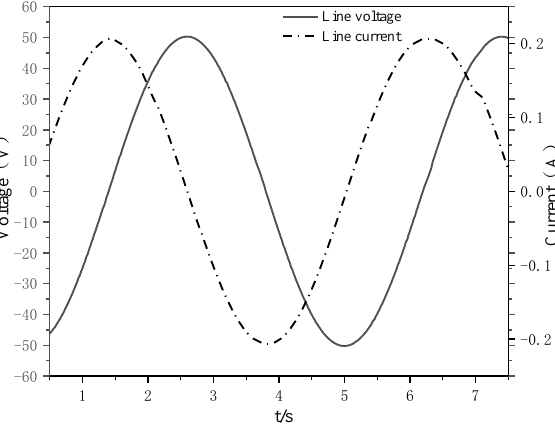
Figure 6. Line voltage and line current under electrical-magnetic simulation.